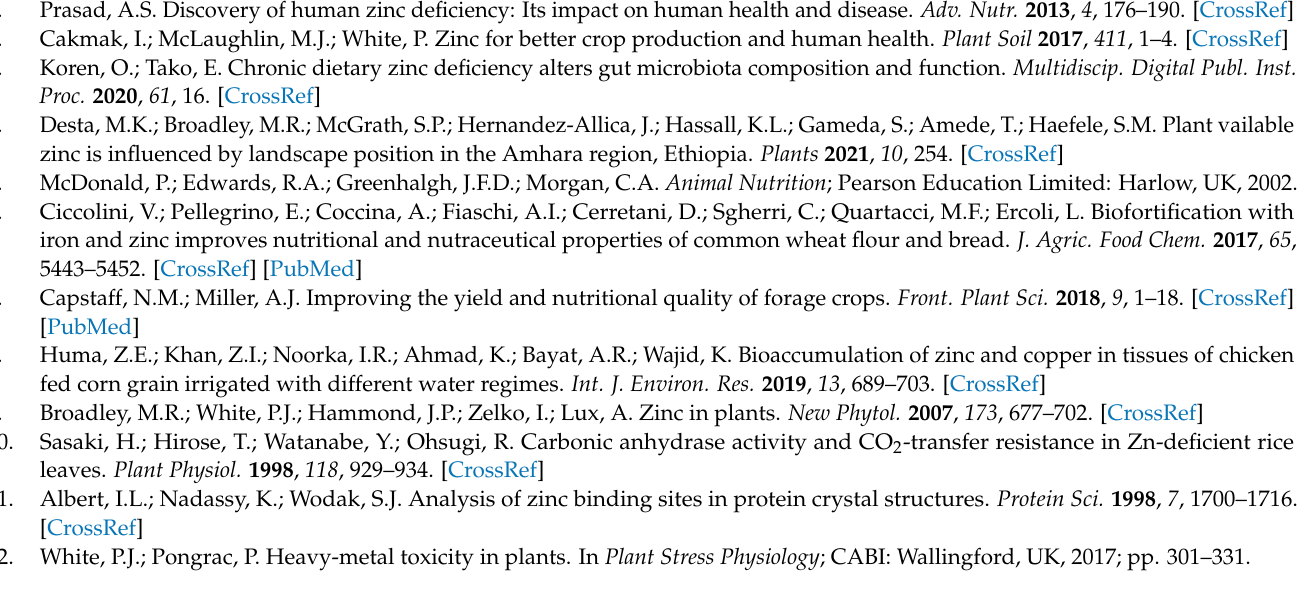
of the reference genes. Table S1: Fresh and dry weight of shoots and roots of alfalfa after leaf Zn application. Material and methods S1: PCR